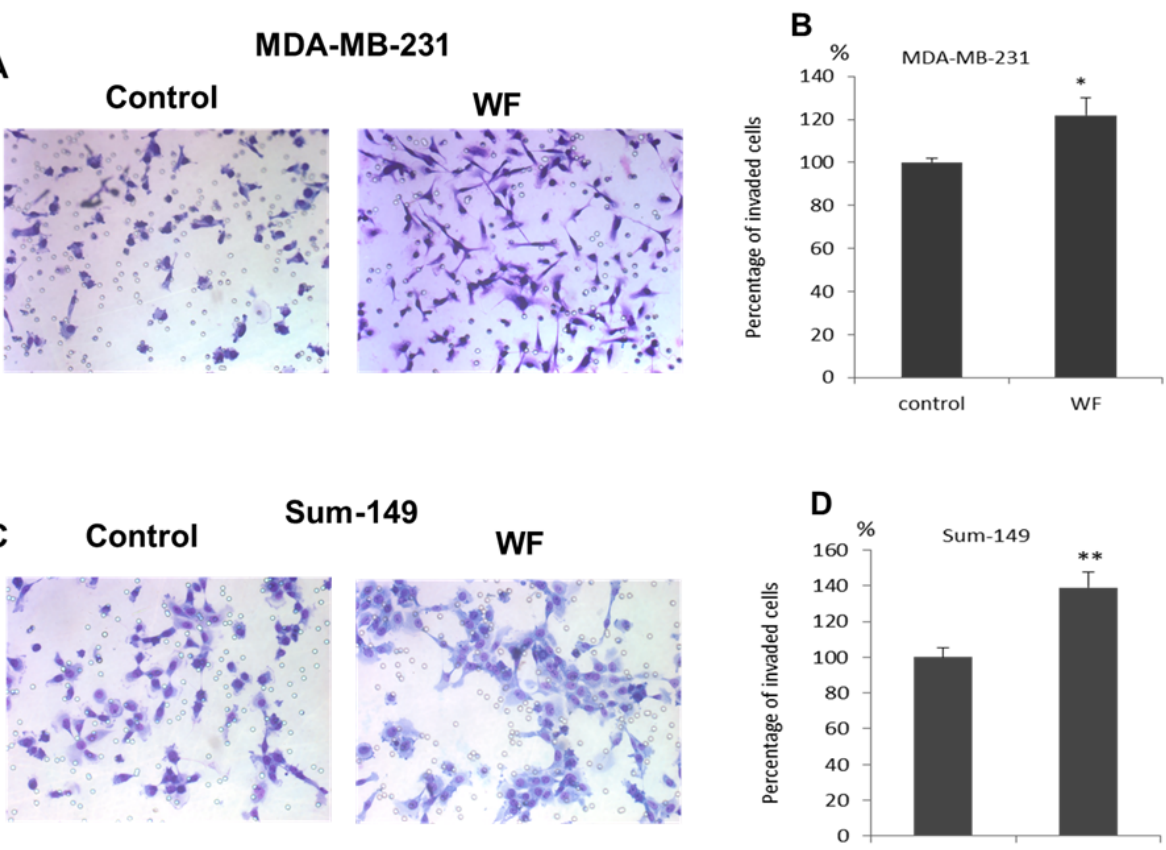
Figure 3. WF induces invasion of MDA-MB-231and Sum149 cells cultured in WF of non-IBC ( n = 12) and IBC patients ( n = 12). ( A , C ) Images represent the invasiveness of MDA-MB-231 and Sum149 cells through Matrigel-coated filters due to the effect of 20% WF placed in the lower chamber and collected from non-IBC ( n = 24) and IBC ( n = 14) for treated cells and control cells. ( B , D ) Quantification of invaded cells compared to control cells. Results are expressed as mean ± SEM; ** represents p ≤ 0.001 and * p < 0.004 as determined by Student’s t -test.